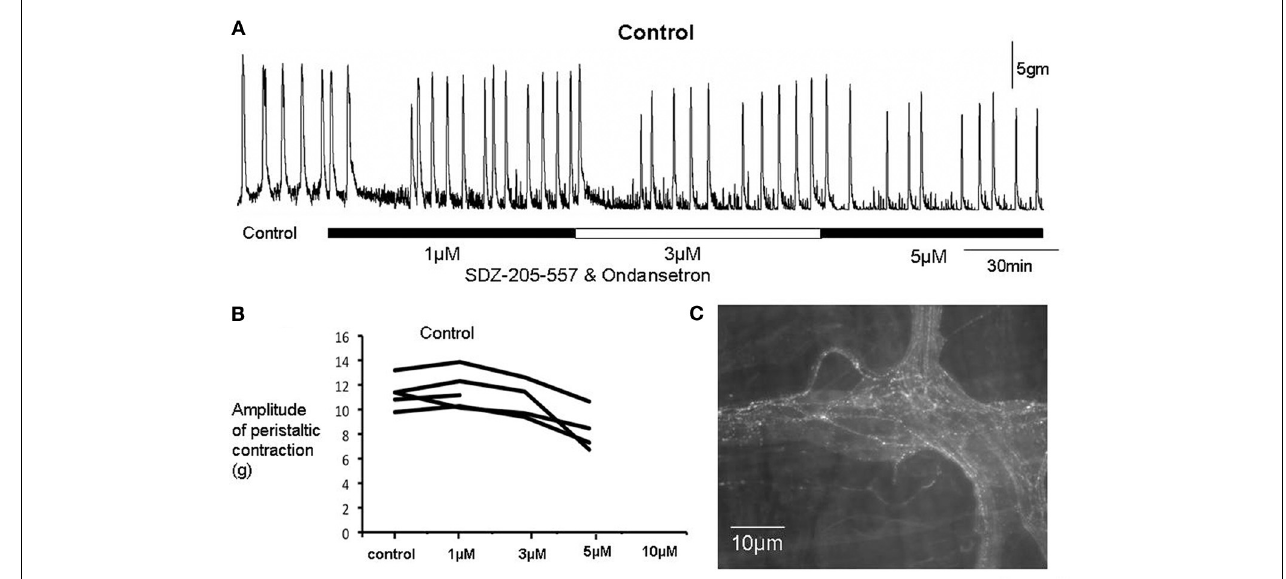
FIGURE 2 | Effects of ondansetron and SDZ 205-557 on a control colonic preparation. (A) On each occasion when increasing concentrations of both antagonists were applied a temporary blockade of peristaltic contractions occurred. However, in the continued presence of both drugs, contractions recovered with characteristics not detectably